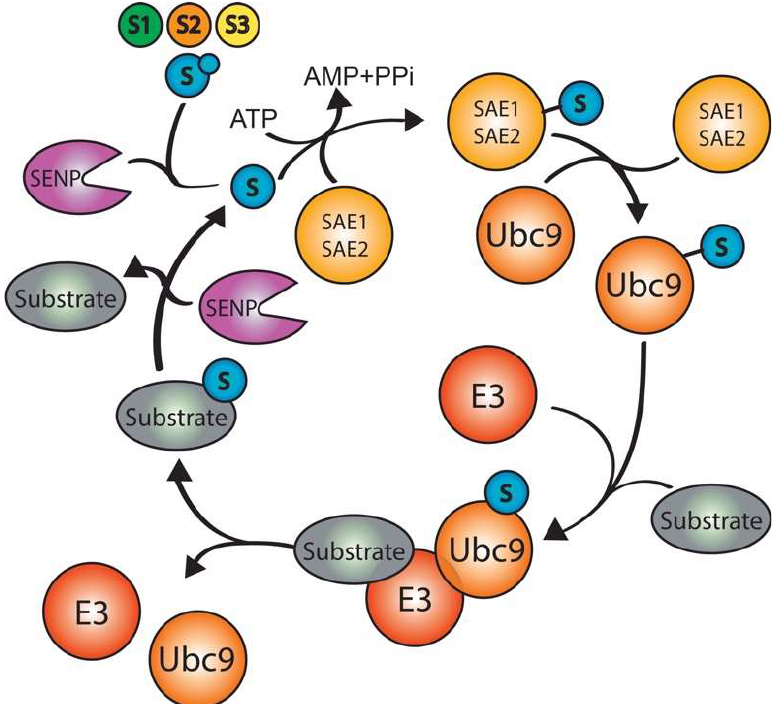
Figure 5. SUMOylation cascade. SUMO precursor matures by the action of a SENP that cleavages the SUMO C-terminal, leaving a diGly motive that forms a thioester bond with the activating enzyme E1 in an ATP dependent manner. Then, activated SUMO is transferred to the conjugating enzyme E2. Finally, the E2 conjugates SUMO to the acceptor lysine (usually in the consensus motive ψ KxE) with or without the ligation enzyme E3 which confers substrate specificity. Additional rounds of this cascade form SUMO polymers that can be cleaved by specific SENPs. In contrast to the ubiquitin system where more than 600 ubiquitin E3 enzymes have been elucidated, only a few SUMO E3 enzymes have been discovered. SUMO E3 activity in vivo and in vitro was observed for first time in 2001, where SIZ1 and SIZ2 SUMO E3s were required for most SUMO conjugation in yeast [101] and PIAS1 acted as a SUMO E3 towards p53 in human cells [102]. In mammals, unrelated classes of proteins appear to act as SUMO E3 enzymes, including the protein inhibitor of activated STAT (PIAS) family, the nuclear pore complex (NPC) component RanBP2, the zinc finger 451 (ZNF451) class, the SLX4 complex and other possible SUMO E3 enzymes that enhance SUMOylation of one or more substrates such as the human polycomb protein Pc2/CBX4, topoisomerase I binding protein (TOPORS), the transcription factor Krox20, the tumor suppressor p14/Arf, the histone deacetylase HDAC4, and the Ras homologue enriched in striatum (Rhes) which must be further evaluated (Table